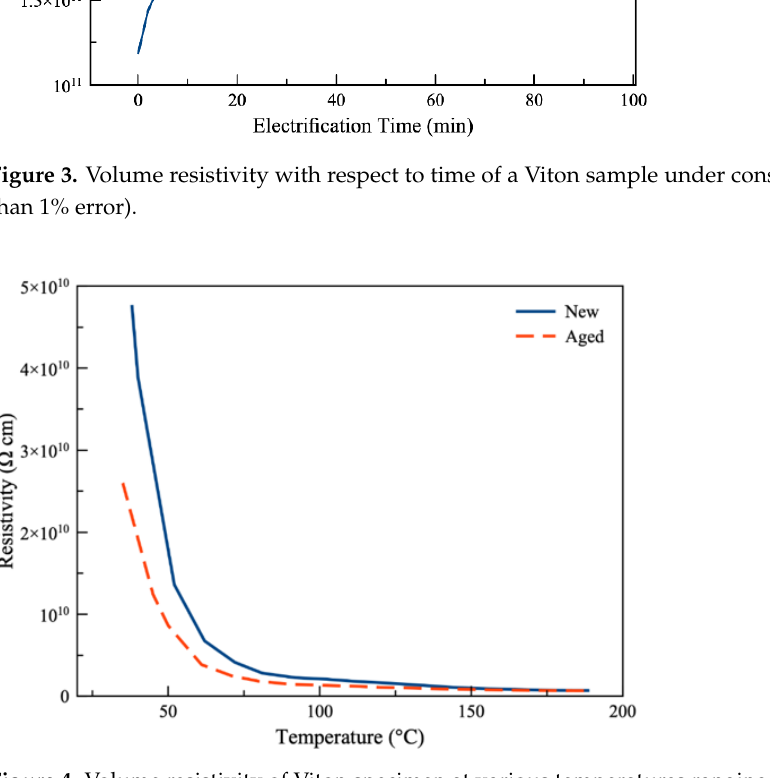
Figure 4. Volume resistivity of Viton specimen at various temperatures ranging from 35 to 190 °C at 500 V (less than 2% error).